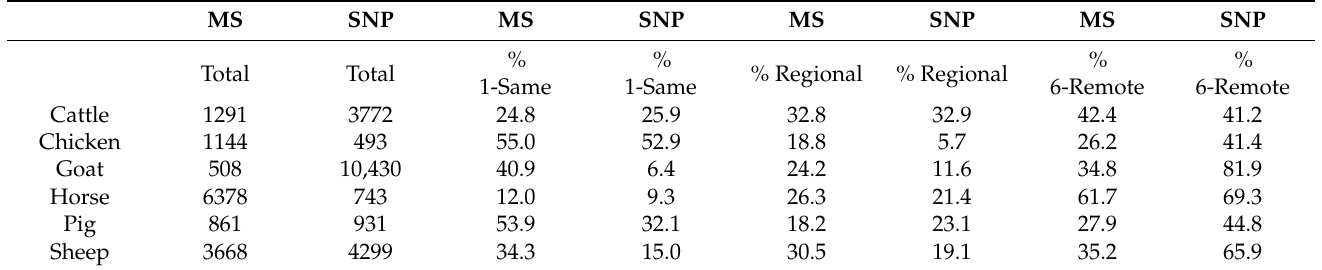
Table 6. Proportions of breed pairs in each geographical class, compared between